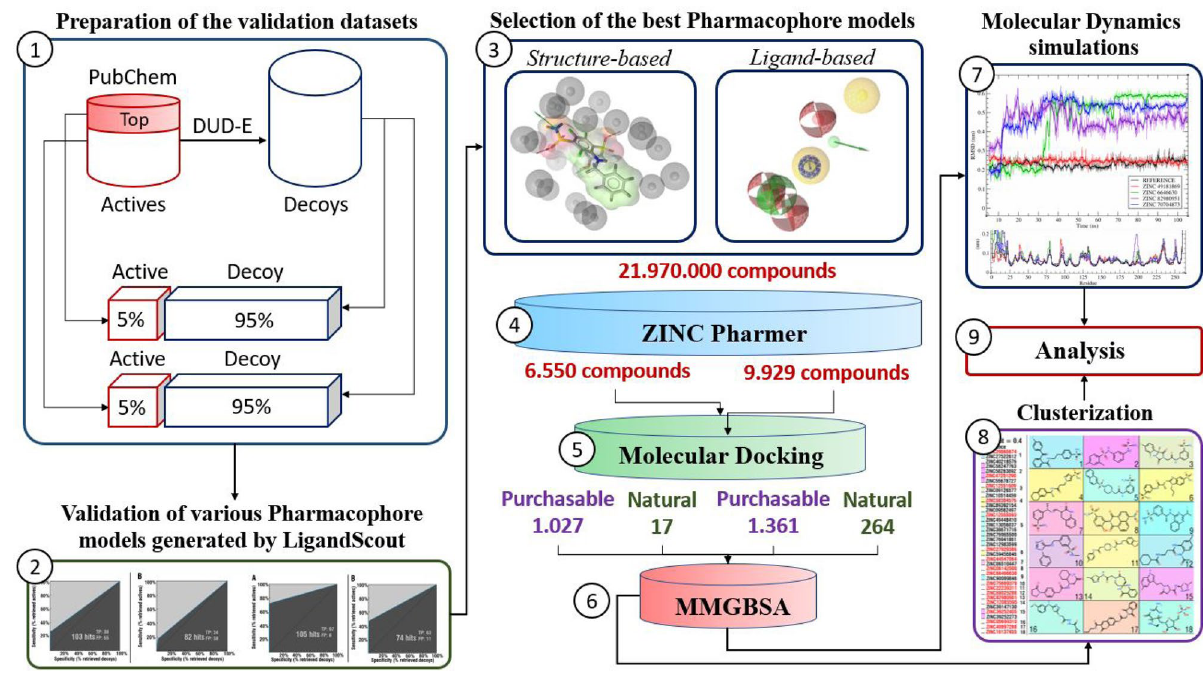
Figure 1. Schematic representation of general methodology and approaches applied in the study. Schematic illustration was drawn using Adobe Illustrator 2018 (www. adobe. com/ produ cts/ illus